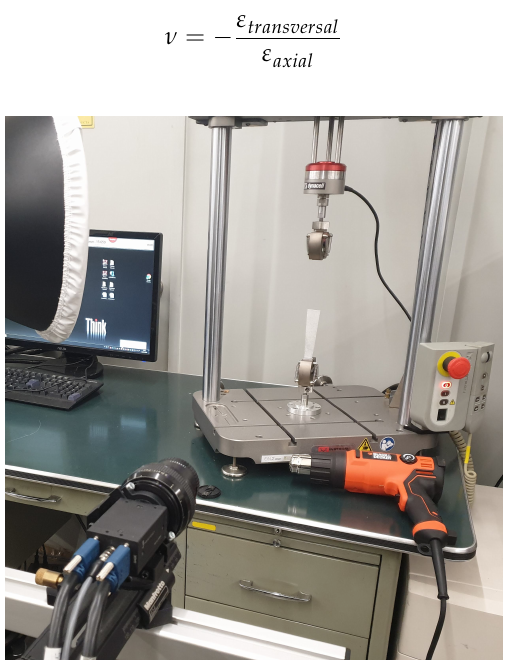
Figure 14. Setup used for the measurement of the blade’s Young modulus and Poisson ratio.